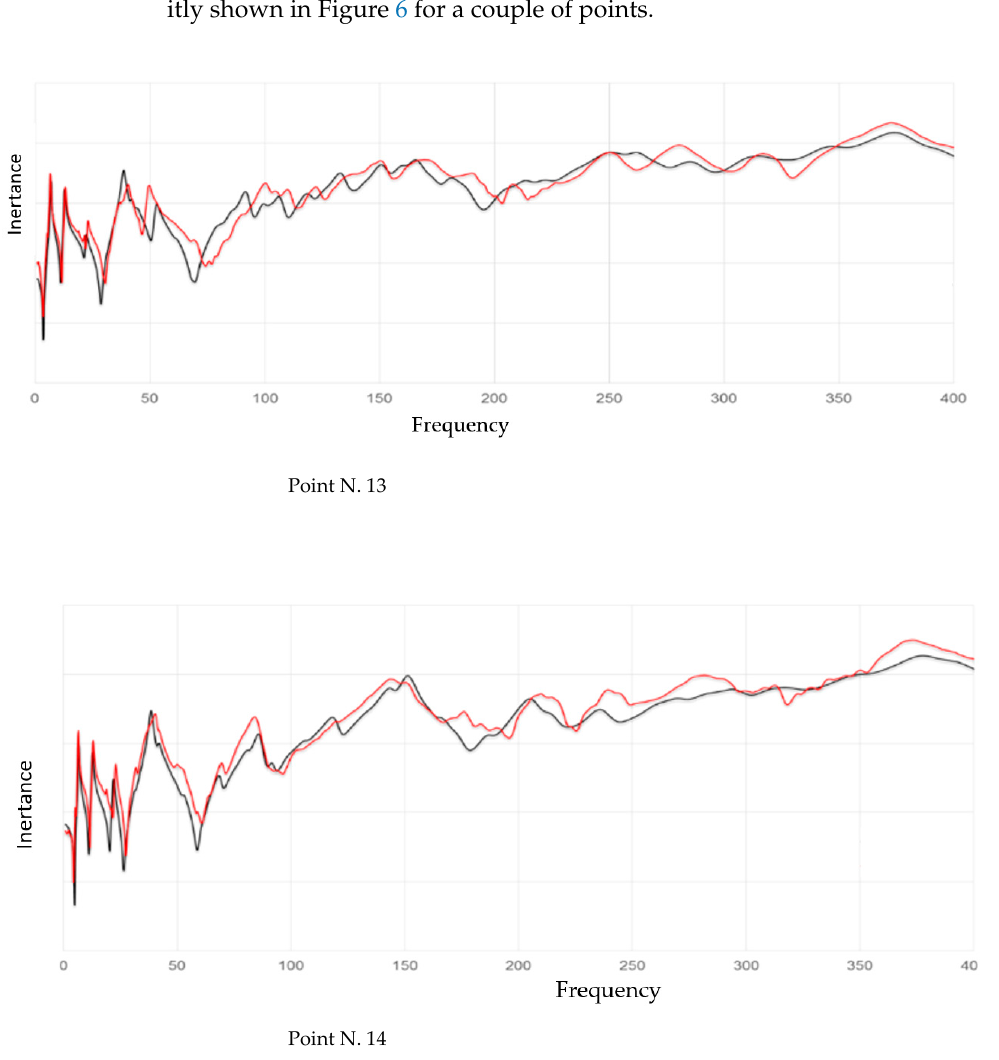
Figure 6. Numerical (black line) and experimental (red line) inertances vs. frequency (Hz) for the shelter component at points N. 13 and 14 (see Figure 4).